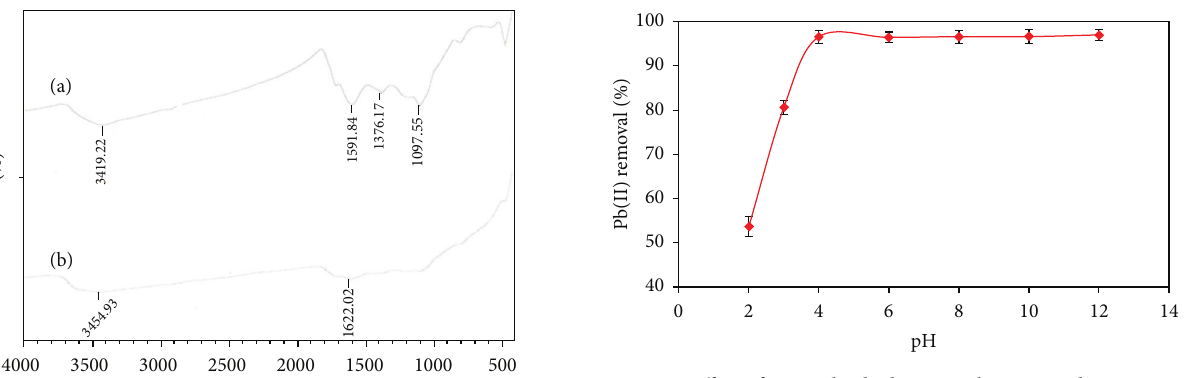
Figure 4: Effect of pH on lead adsorption by activated maize tassel (contact time: 60min; dosage 1.2g; initial concentration 10mg/L; error bar = ± S.D.; and 𝑛 = 3 ).